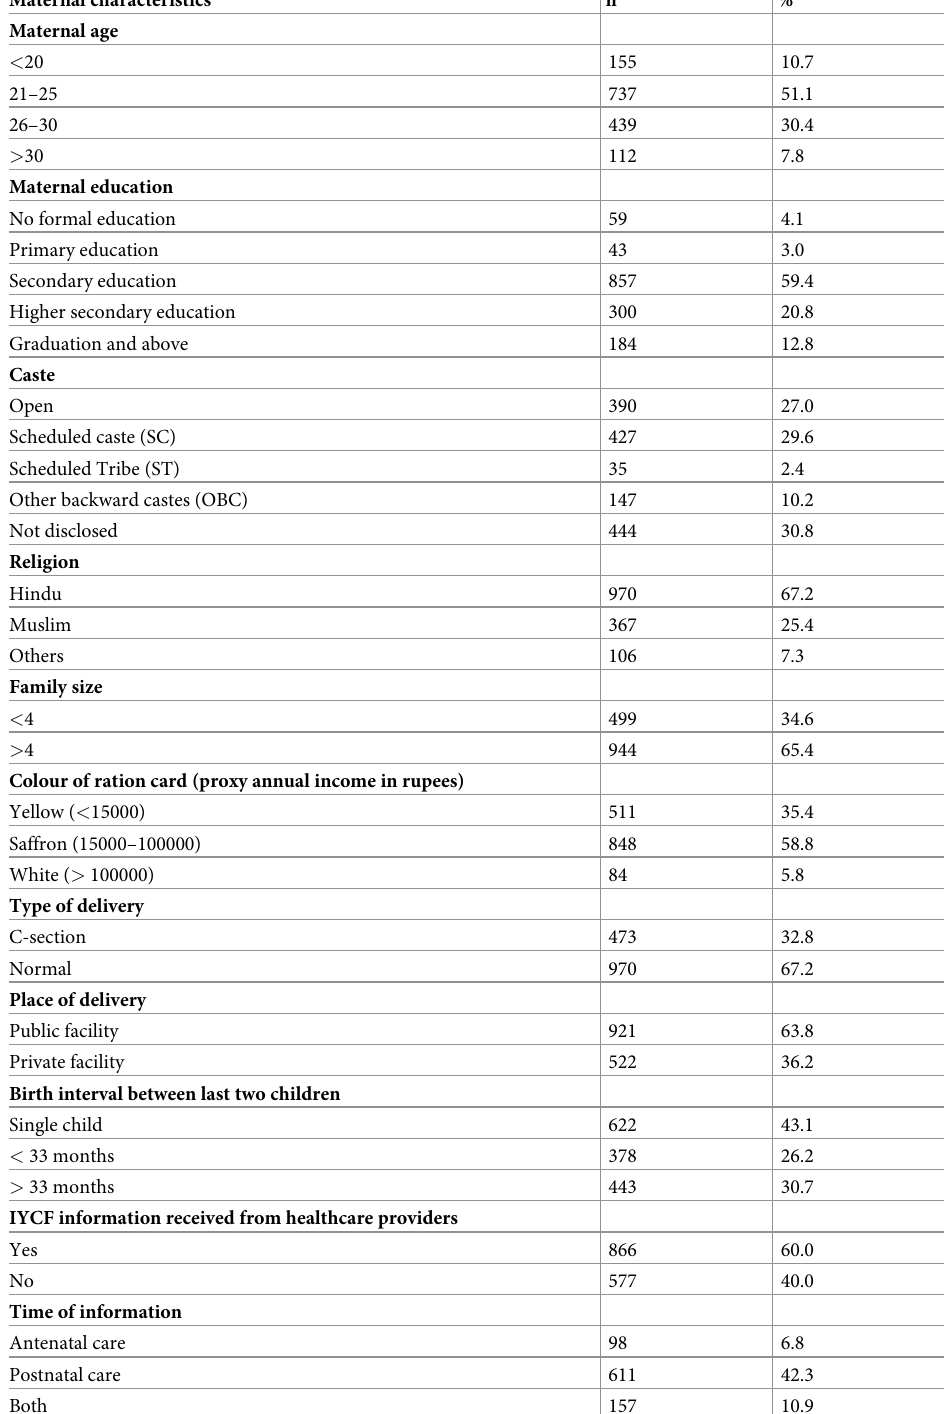
Table 1. Distribution of socio-demographic and obstetric characteristics of respondents (N =